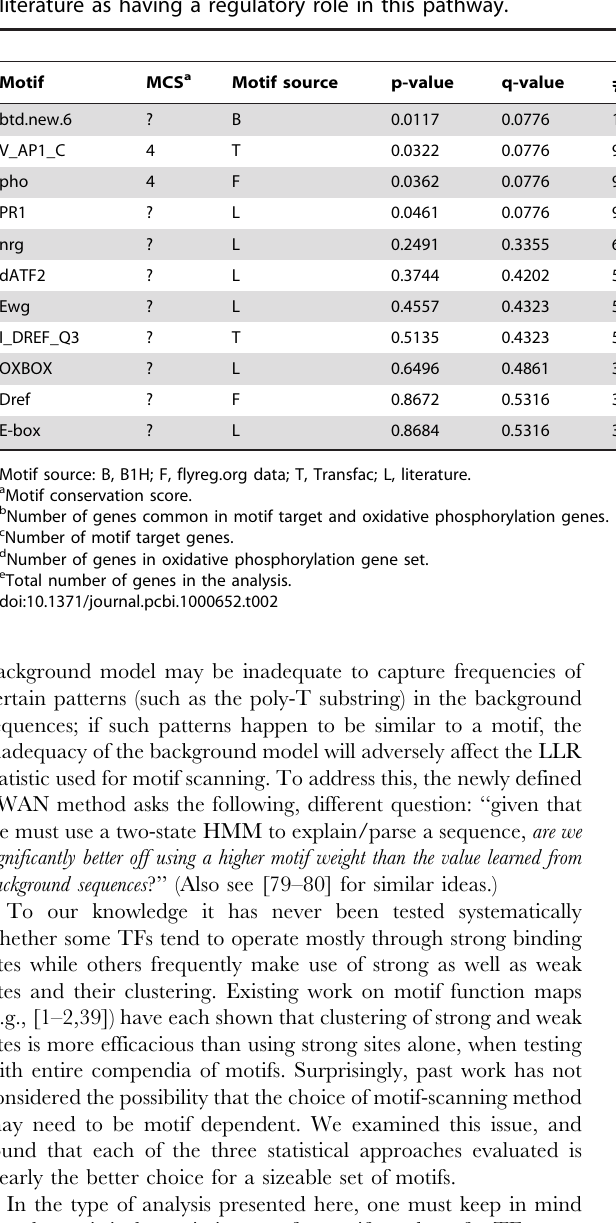
Table 2. Enrichment p-values for the oxidative phosphorylation gene set in Nasonia , shown here for ten motifs implicated in the literature as having a regulatory role in this